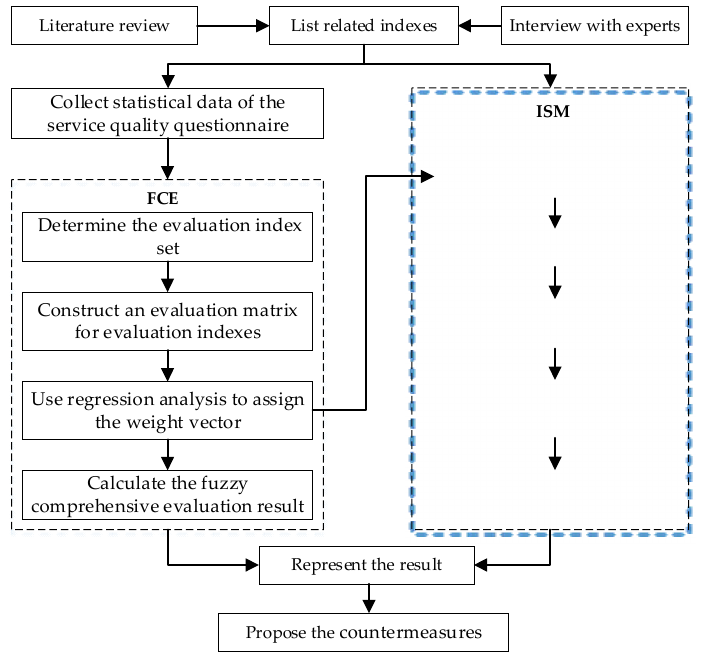
Figure 2. Flowchart of the integrated methodology.